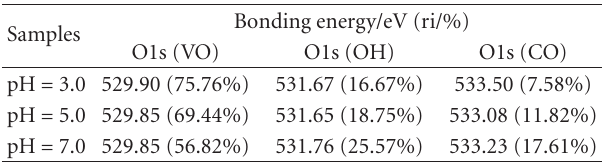
Table 2: Binding energy and area percentage of BiVO 4 (s-m) for the O1s region under di ff erent